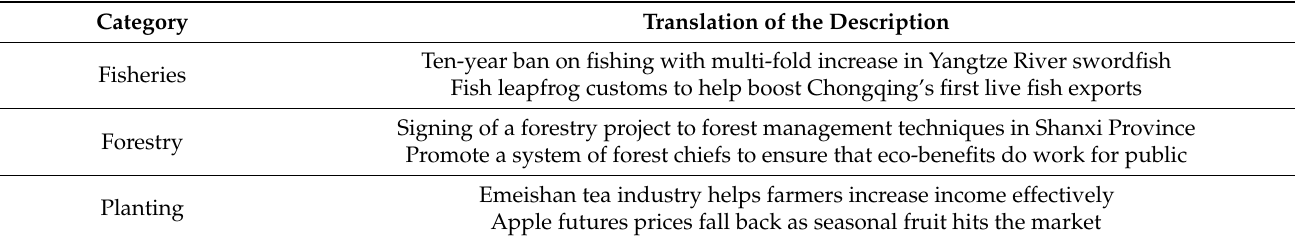
Table 2. Examples of data set